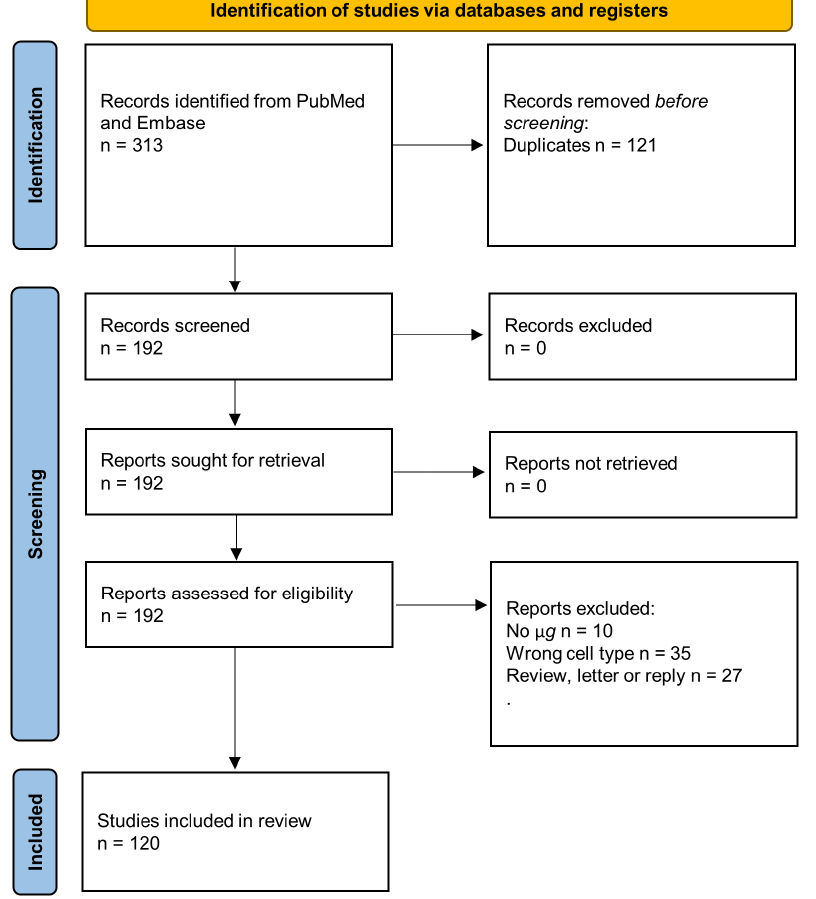
Figure 7. PRISMA 2020 flow diagram: results of the literature search (different types of cancer cells exposed to microgravity/space) for this comprehensive review.